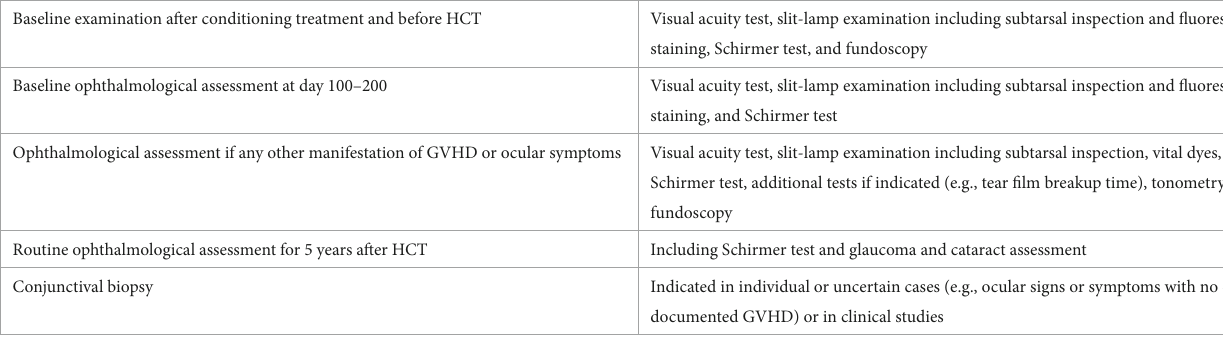
Baseline ophthalmological assessment at day